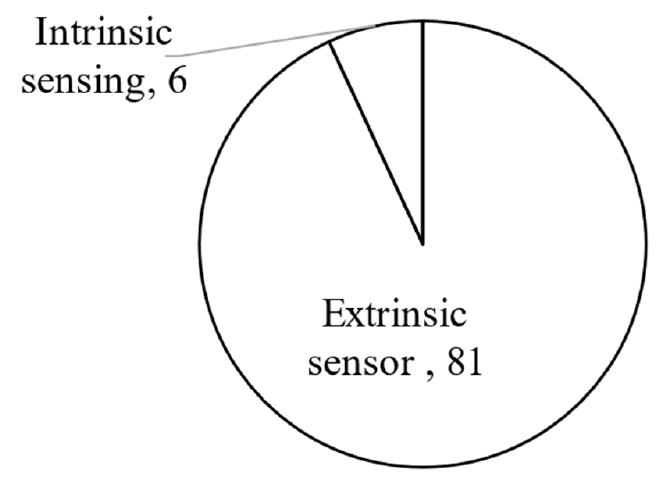
Figure 19. The numbers of publications using extrinsic sensors and intrinsic sensing.